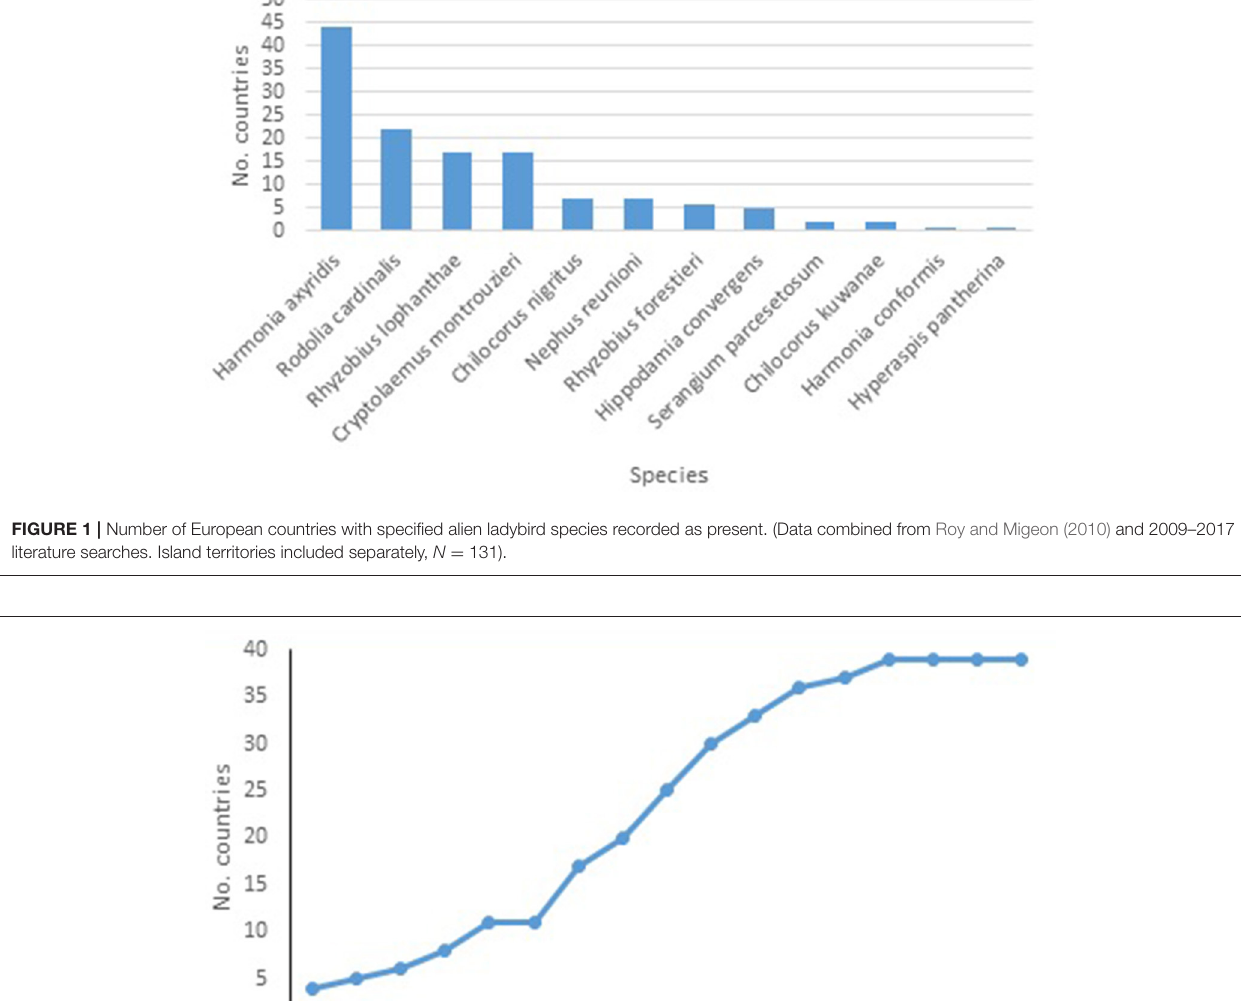
Food Relationships of European Alien The majority of the alien coccinellid species in